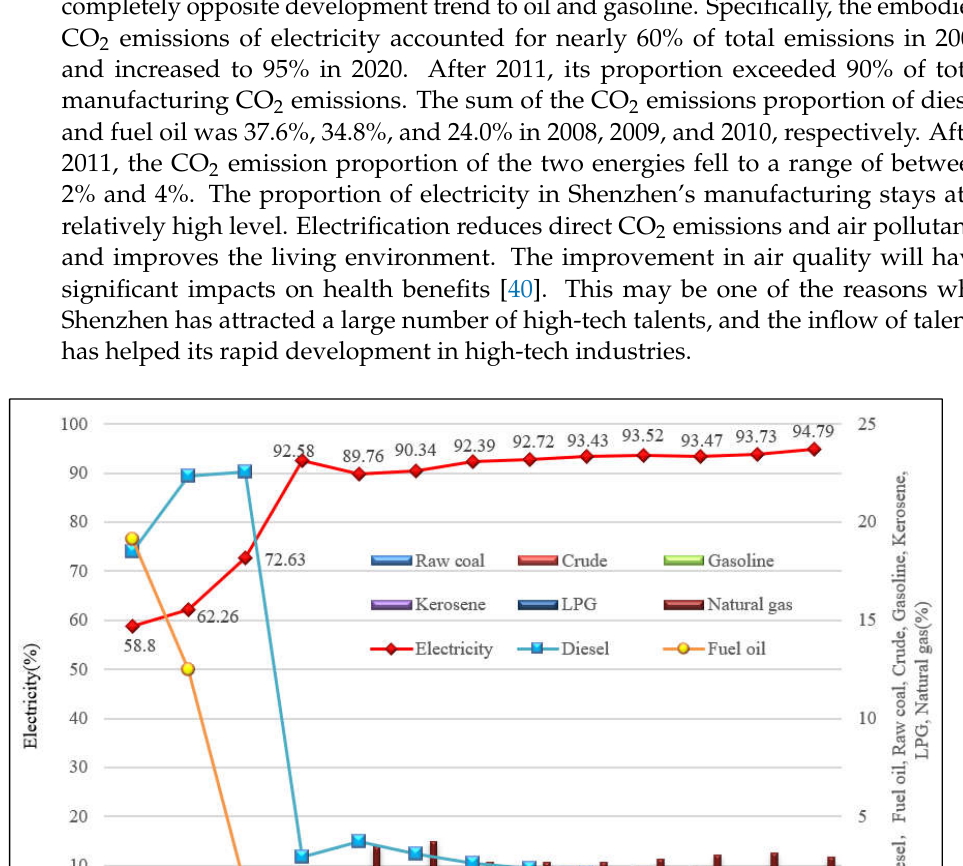
(1) Industry heterogeneity. Figure 3 shows the industry heterogeneity of CO 2 emissions from manufacturing in Shenzhen during 2008–2020. According to industry charac- teristics, 27 sub-sectors are divided into four categories, revealing the sector structure of CO 2 emissions from Shenzhen’s manufacturing. Specifically, electronic equipment manufacturing is the primary sector responsible for energy emissions, accounting for nearly 34.93% of total manufacturing emissions in 2008 and increasing to 47.43% in 2020. Before 2012, the proportion of its emissions was slightly reduced to about 30% but has gradually increased since. The emission proportion of light industry to the total proportion of manufacturing has dropped from 16.86% in 2008 to 8.26% in 2020. During the period under study, the emission share of equipment manufacturing and others in manufacturing decreased from 32.1% to 27.73%. The emission proportion of the raw material processing industry increased slightly and then decreased slightly, and the proportion in 2020 (16.57%) and 2008 (16.11%) is basically the same.